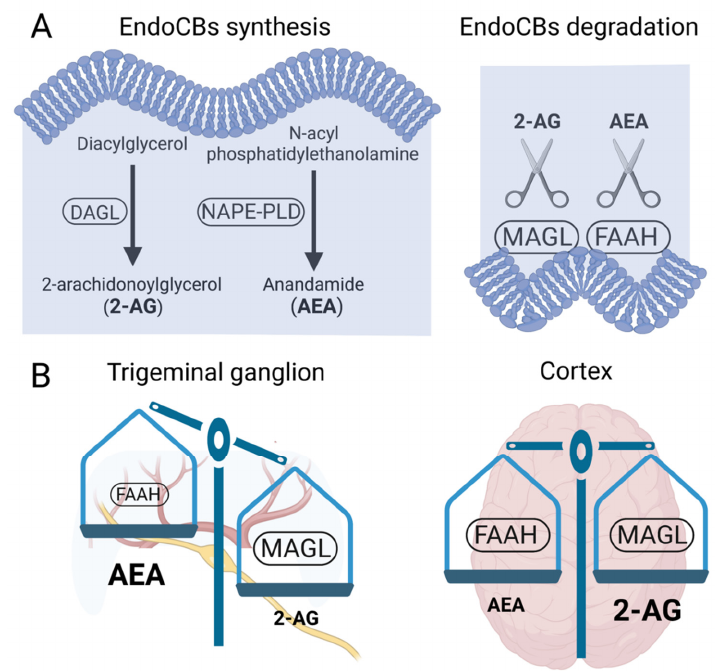
Figure 2. EndoCBs synthesis, degradation and distinct MAGL and FAAH profiles in migraine pain pathways. ( A ) Main enzymatic steps of 2-AG and AEA synthesis and degradation. ( B ) Text size of enzymes and endoCBs is used to emphasize the relative enzymatic activity and endoCBs levels in the trigeminal ganglion and in cortex. On the left, MAGL, in contrast to FAAH, is the prevalent